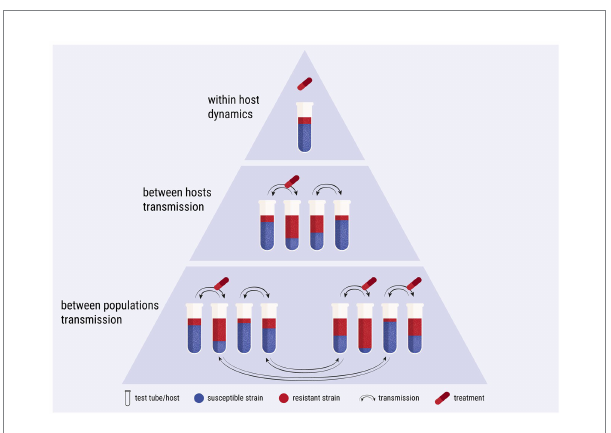
FIGURE 2 Diagrammatic representation of the three levels of complexity of the study. The first level explores the within-host dynamics of the system. The second level focuses on between-hosts dynamics and bacterial transmission. The third level is expanded to include two host populations with transmission between